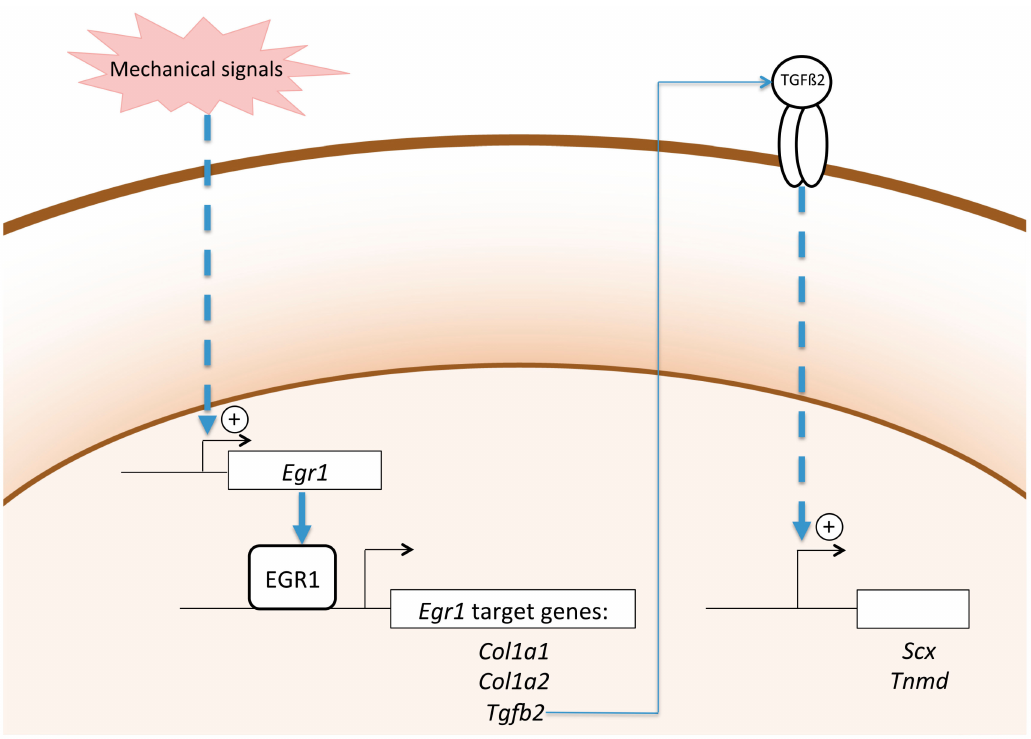
Figure 4. Schematic representation of the position of Egr1 / EGR1 in the molecular cascade downstream of mechanical signals involved in tendon gene